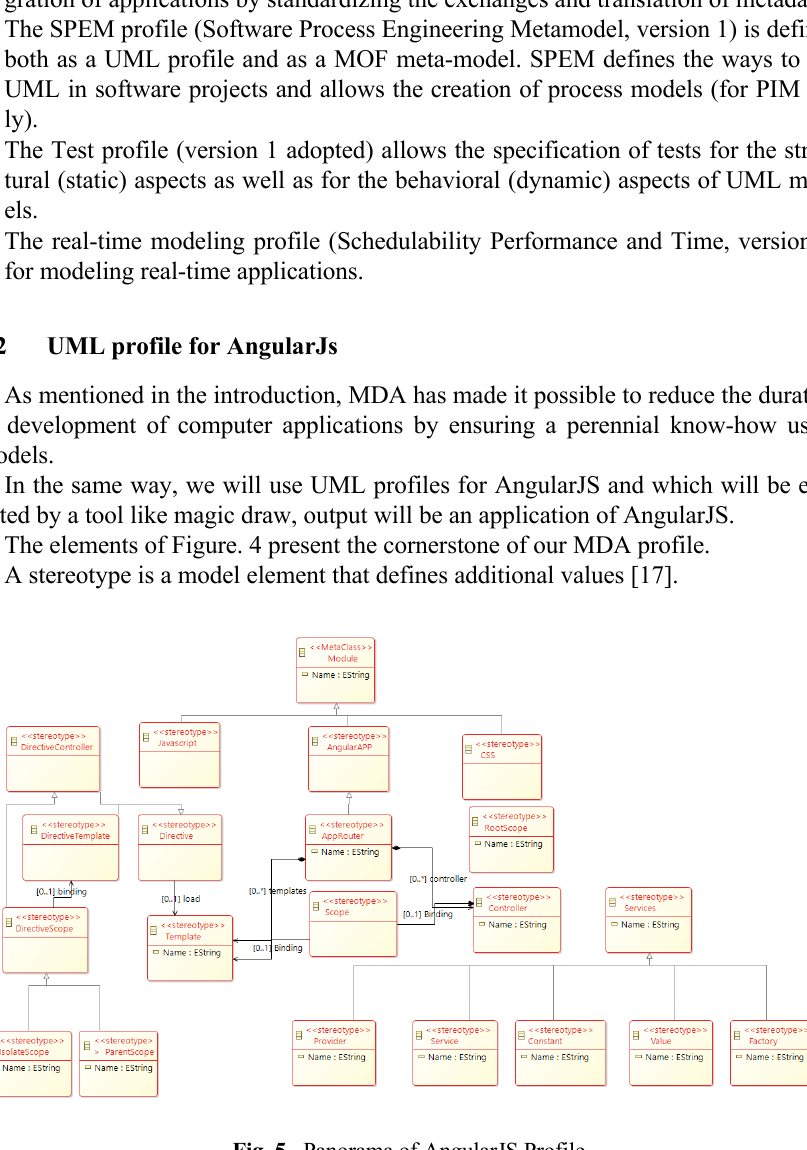
Fig. 5. Panorama of AngularJS